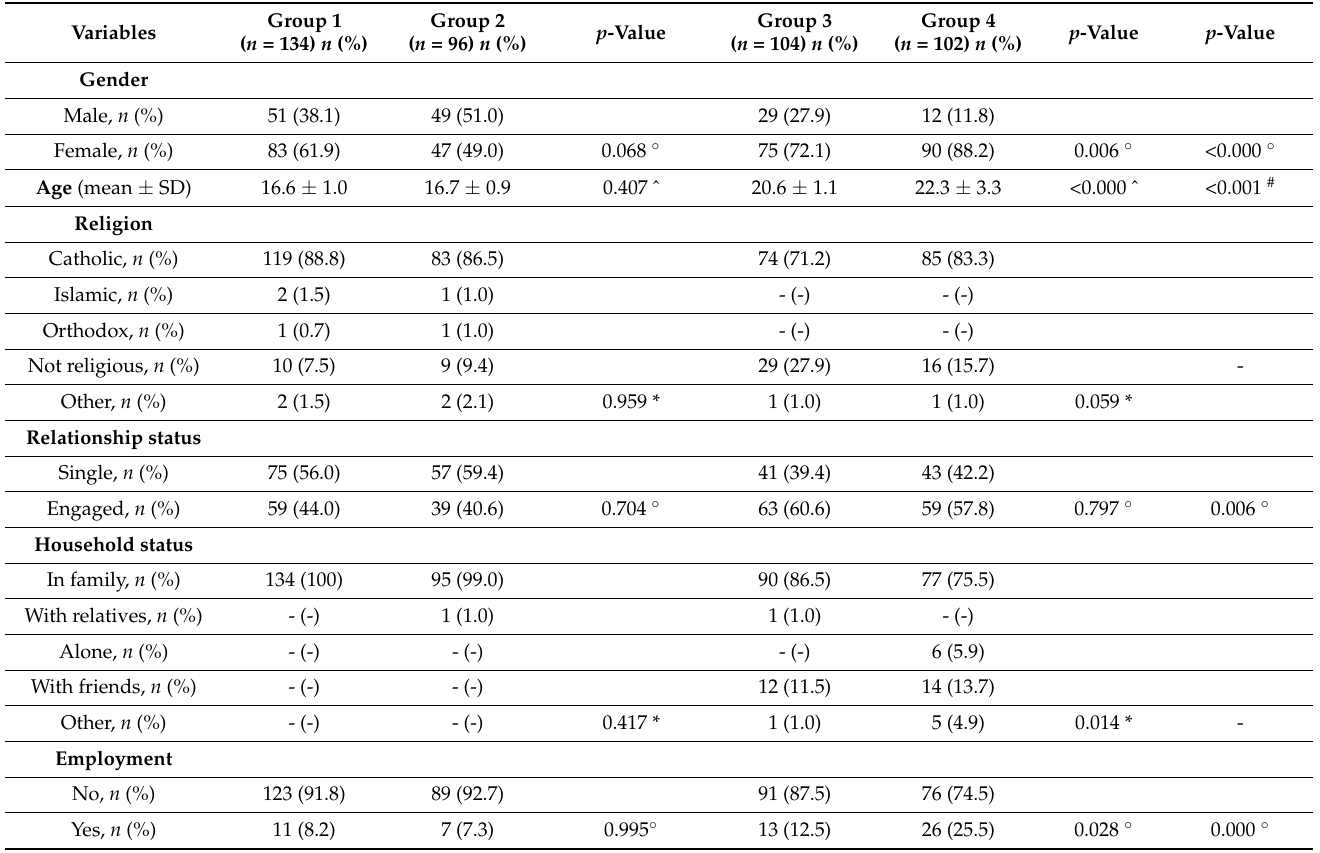
Table 1. Socio-demographic characteristics of